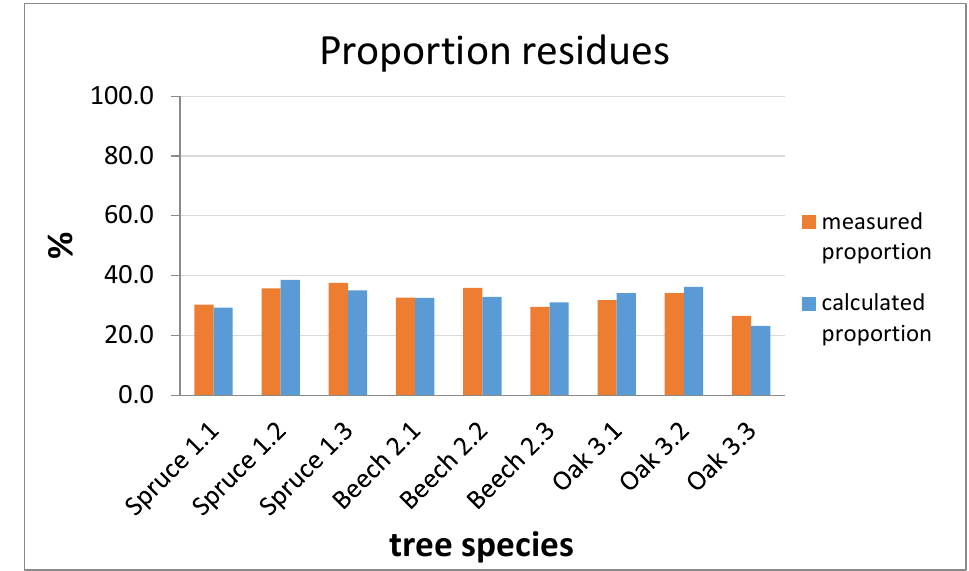
Figure 14. Graphical comparison of the measured and calculated proportion of residues produced from the cutting pattern implementation.